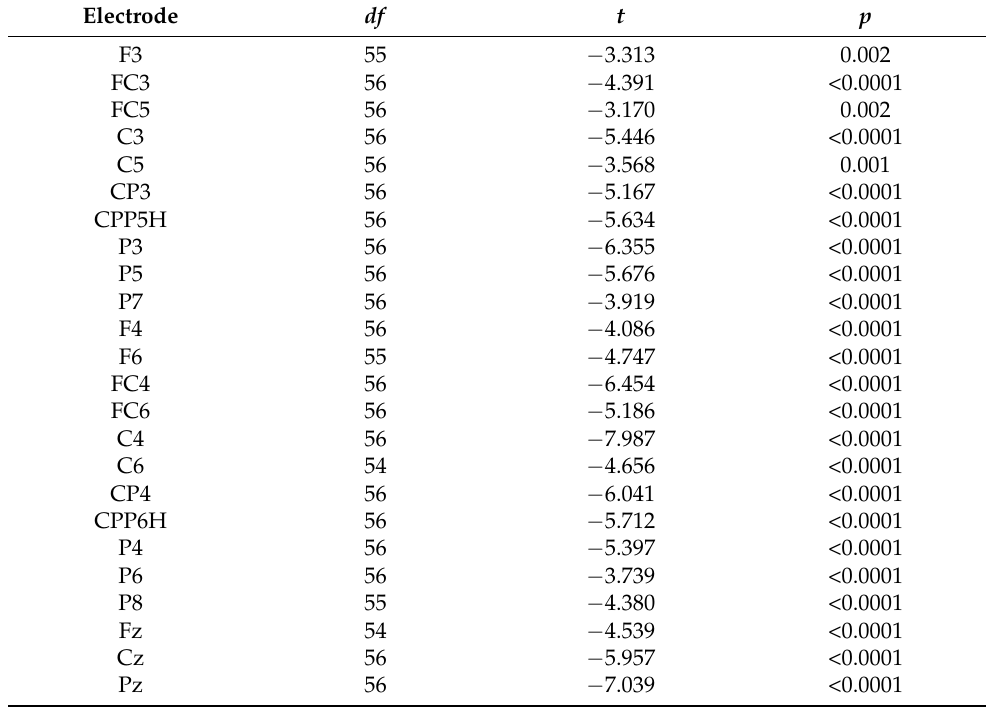
Table A2. Results of post-hoc t -tests comparing congruency levels for time window 420–660